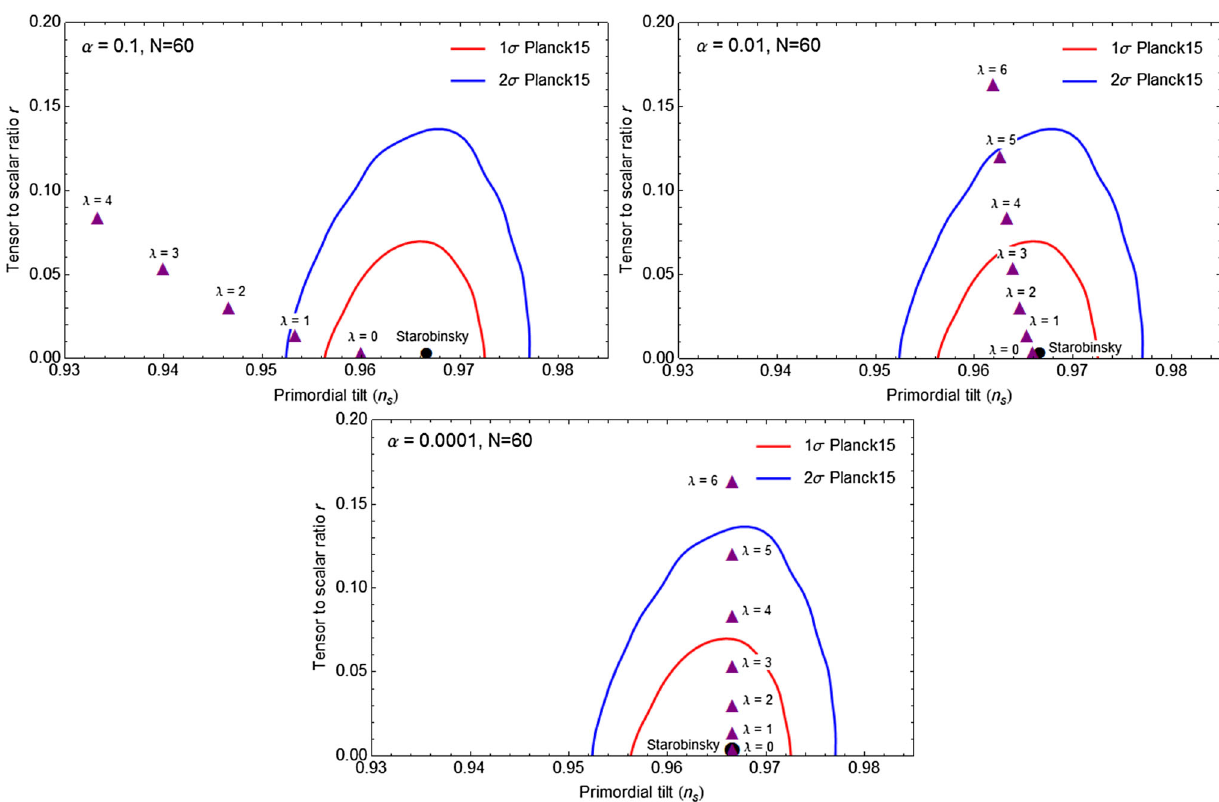
Fig. 1 We compare the theoretical predictions in the ( r − n s ) plane for different values of λ using α = 0 . 1 , N = 60 (uper-left panel); α = 0 . 01 , N = 60 (uper-right panel) and α = 0 . 0001 , N = 60 (lower panel) with Planck’15 results for TT, TE, EE, +lowP and assuming (cid:18) CDM+ r